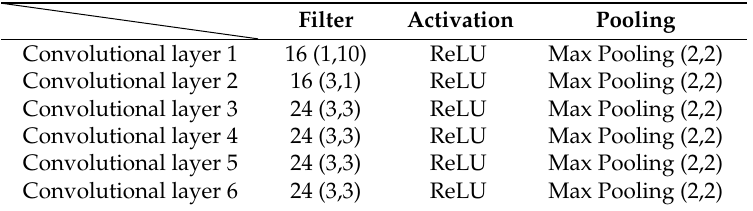
Figure 10. Architecture of CNN model for Lamb-wave touchscreen position sensing. Table 1. Parameters and operations used in convolutional layers.